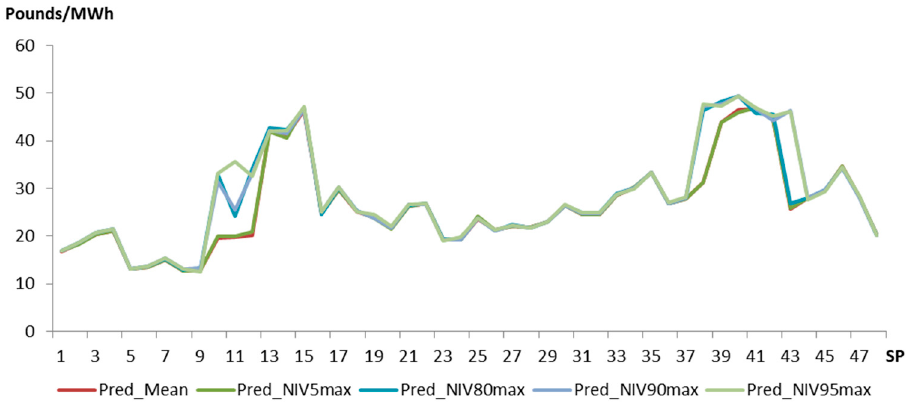
Figure 7. Model price prediction with mean 5%, 80%, 90%, 95%, NetImbVol quantile regression.